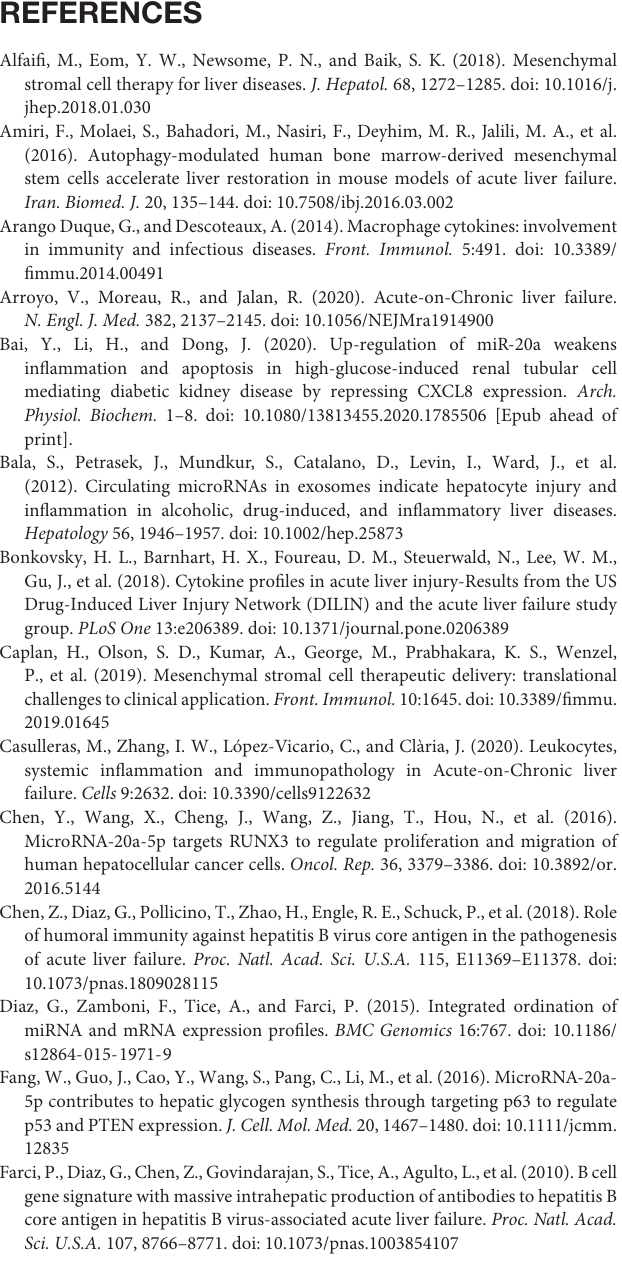
Supplementary Figure 1 | Characterization of primary murine hepatocytes. (A,B) The primary hepatocytes of mice in the NC group and ACLF group were triangular in shape under light microscope. Scale bar = 400 µ m. (C,D) Western blot detection of ALB expression in mouse primary hepatocytes. The relative expression of ALB in primary hepatocytes of the NC group was 95% of that in the AML12 mouse hepatocyte